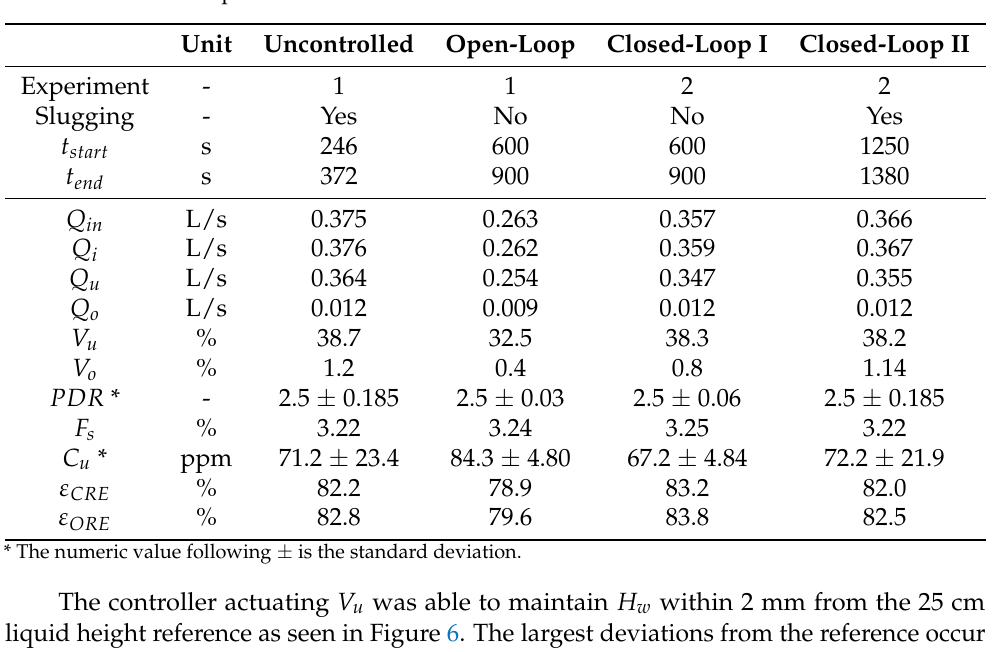
Table 2. Scenario comparison.